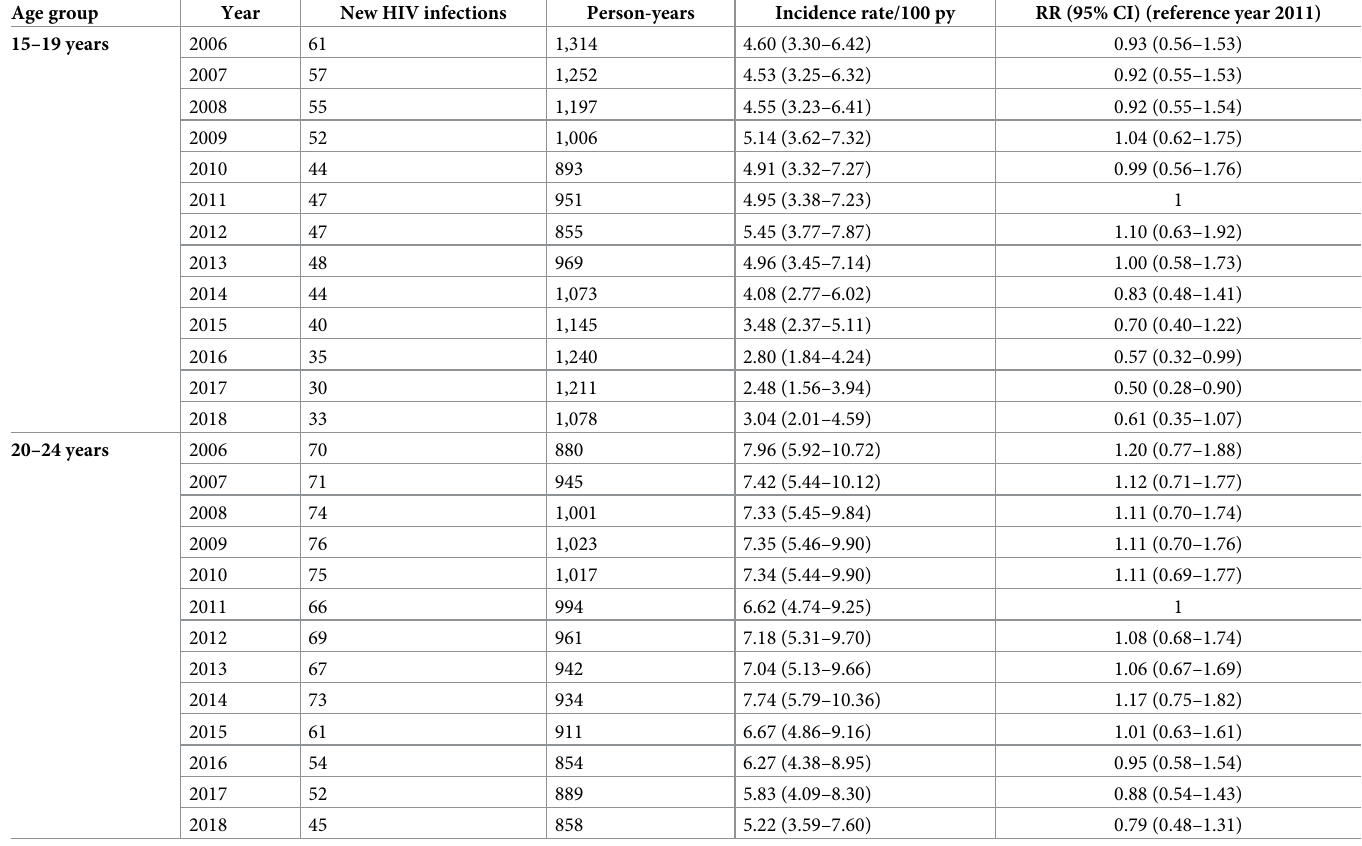
Table 4. Incidence of HIV infection among AGYW, by age and individual year in uMkhanyakude (2006–2018). Age